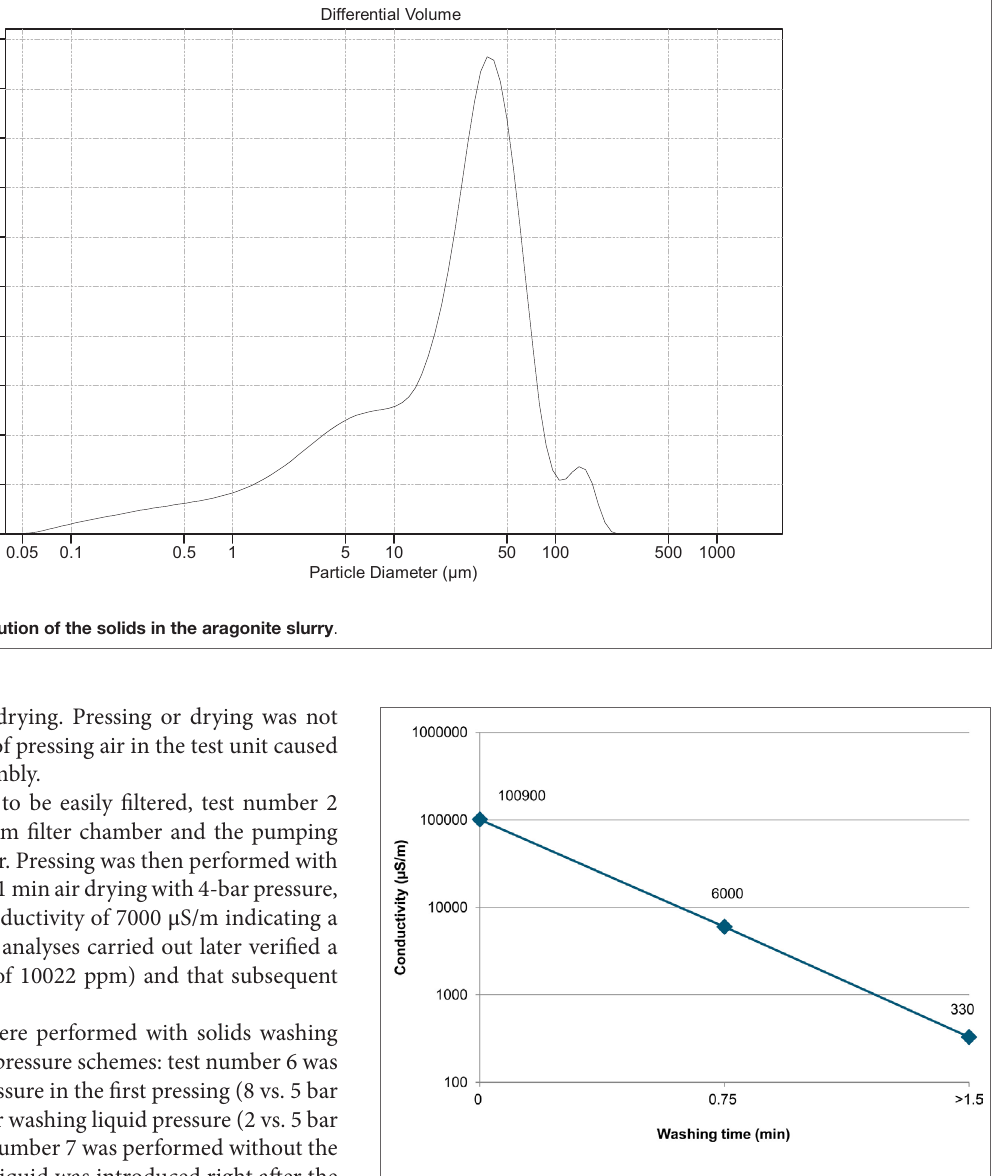
FigUre 7 | Wash filtrate conductivity during solids washing in Test run #7 ( > 1.5 min means that this sample was taken during pressing, after a washing time of 1.5 min)